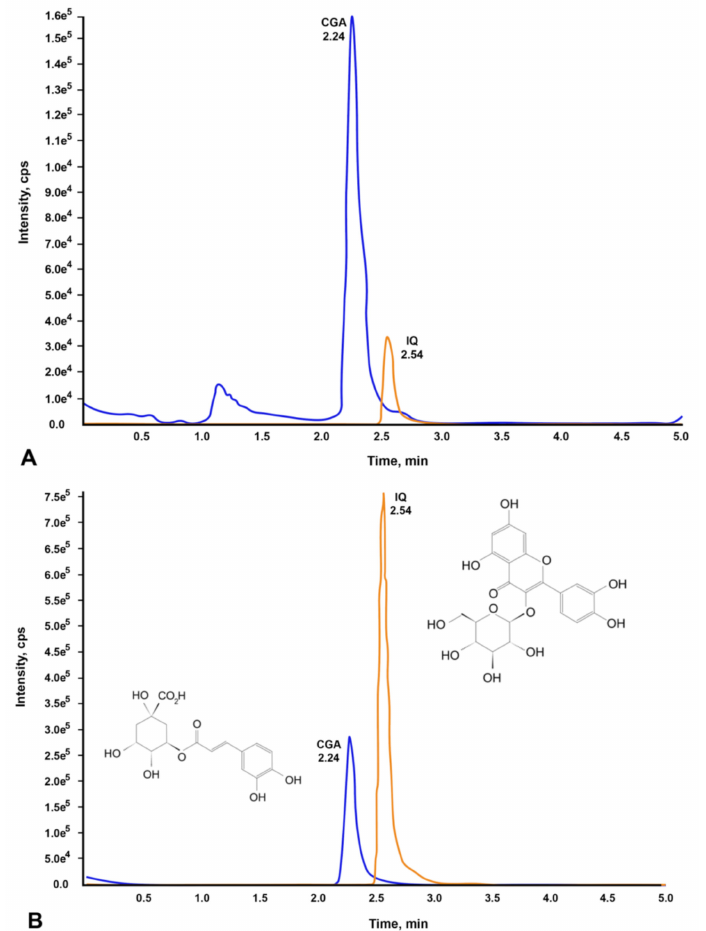
Figure 1. Chromatograms of CGA and IQ found in C. olitorius aqueous extract. ( A ) CGA and IQ present in CO, and ( B ) standard compounds (CGA and